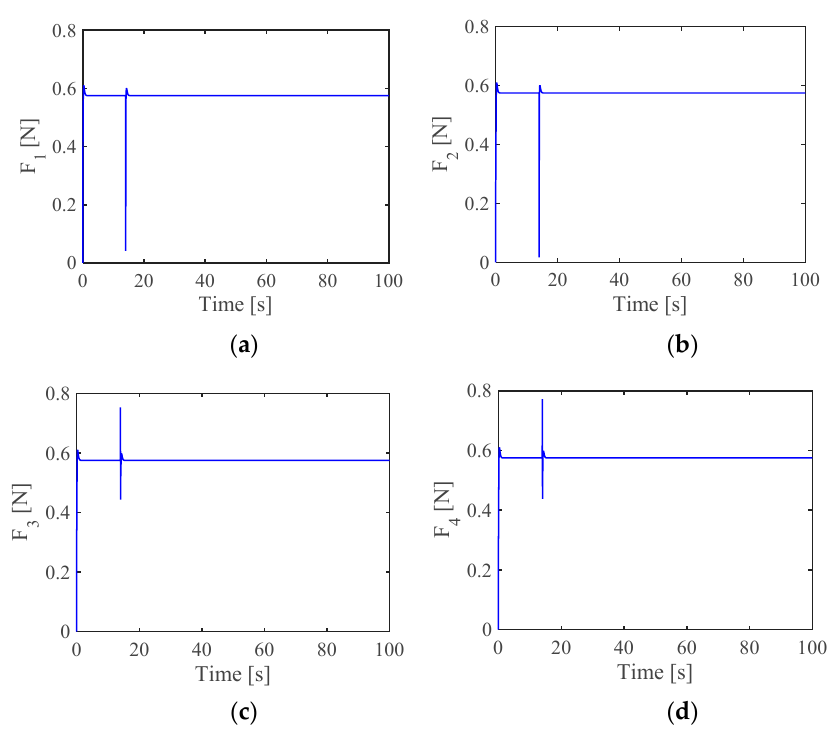
Figure 7. Forces for each of the four motors: ( a ) motor 1 ′ s force, ( b ) motor 2 ′ s force, ( c ) motor 3 ′ s force, and ( d ) motor 4 ′ s force.